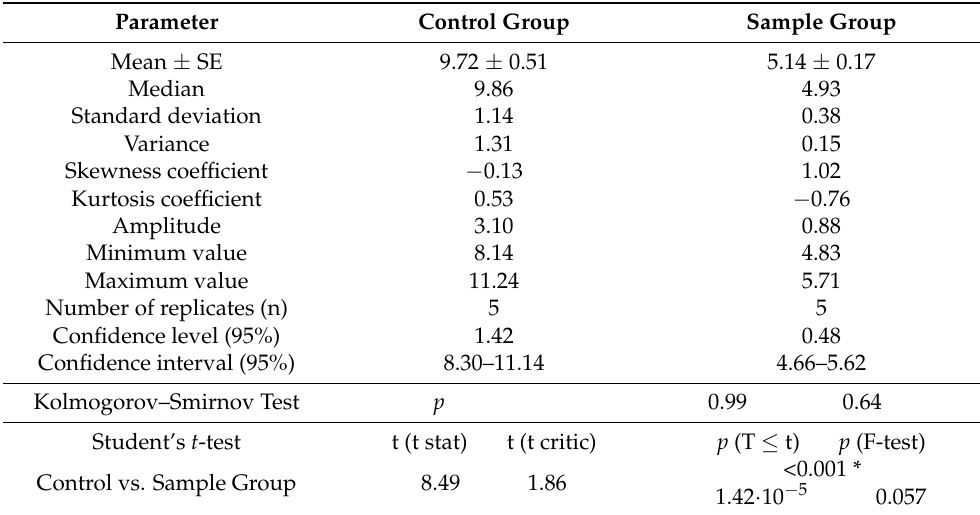
Table 5. Data processing of red blood cell count values (RBC as million/mm 3